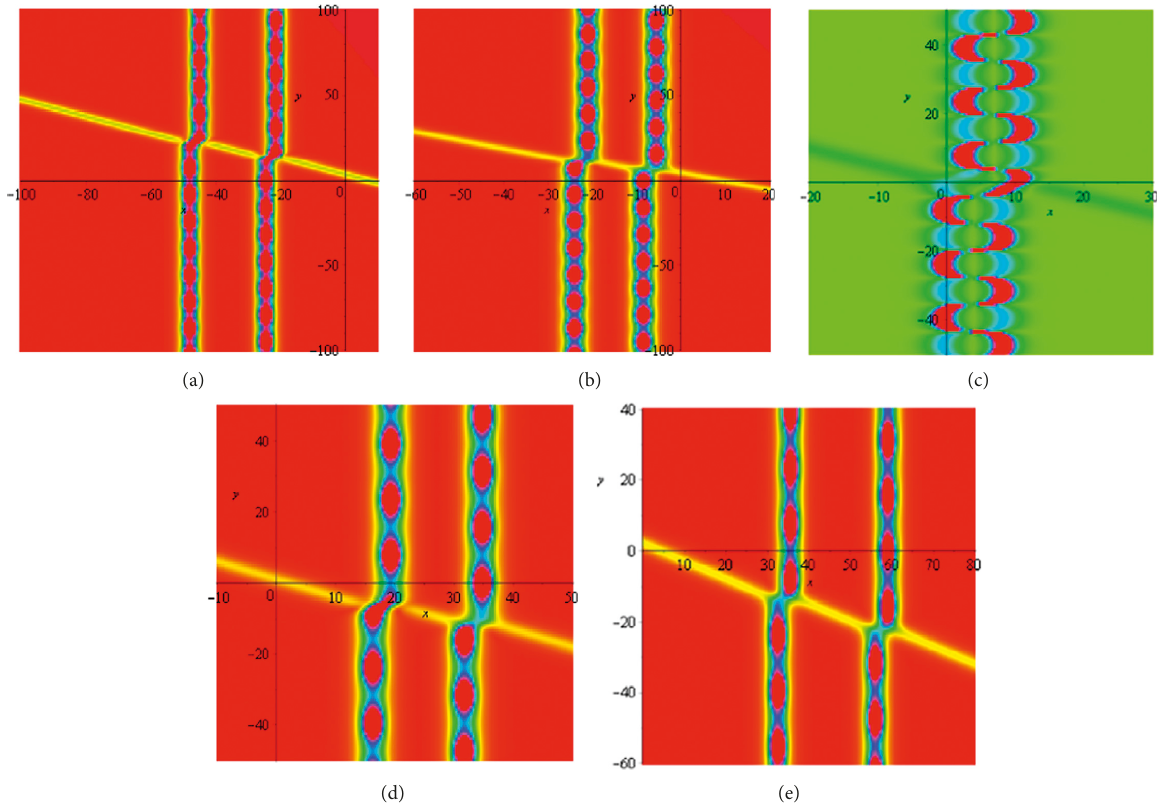
Figure 14: Plots of equation (71) by using c (b) f 2. (c) f 3. (d) f 4. (e) f 5.